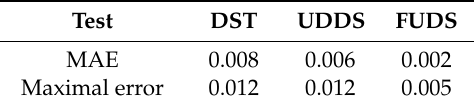
Figure 18. Estimation errors of DST, UDDS, and FUDS tests. Table 7. MAEs and maximal errors of Dynamic Stress Test (DST), Urban Dynamometer Driving Schedule (UDDS), and Federal Urban Driving Schedule (FUDS) tests.